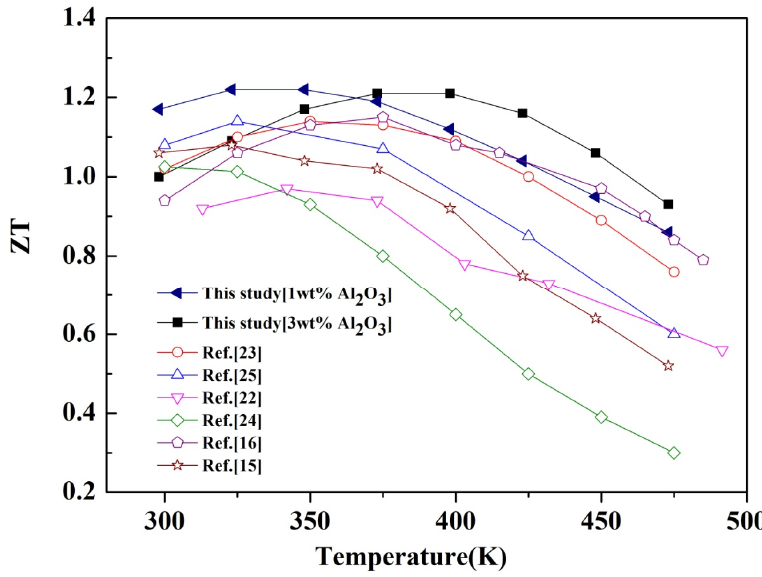
Figure 7. Temperature dependence of ZT of the Bi 0.4 Sb 1.6 Te 3 -based bulk specimens prepared through various methods.